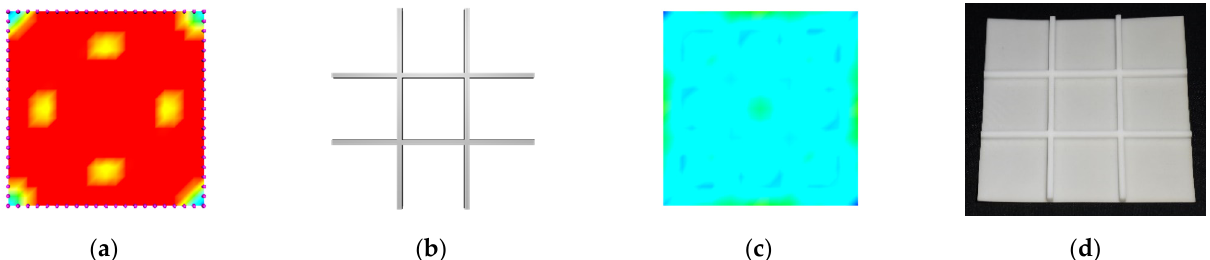
Figure 10. Bidirectionally stiffened square plate, from left to right: ( a ) initial stress without stiffeners; ( b ) optimized stiffeners; ( c ) final stress with stiffeners; ( d ) 3D print.